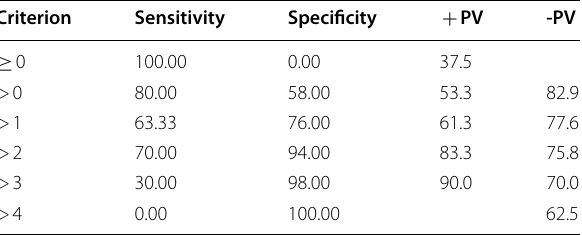
Table 11 Cutoffs, sensitivity and specificity for the total score